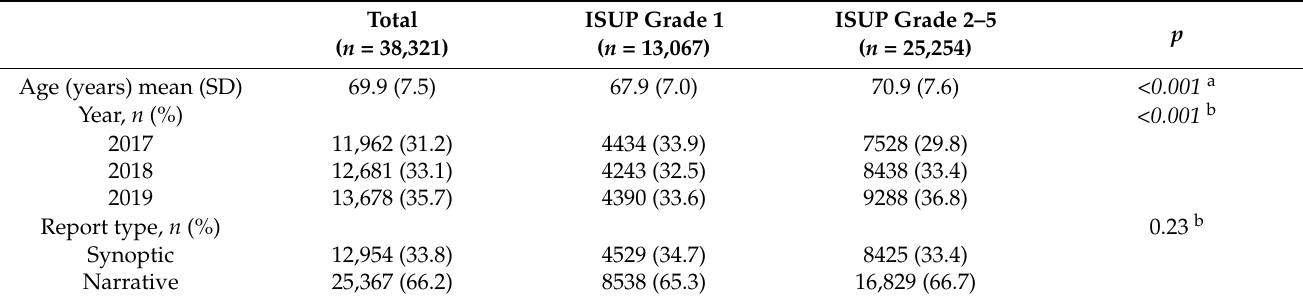
Table 1. Descriptive statistics of the full nationwide Dutch cohort of prostate cancer patients analyzed for grading variation.